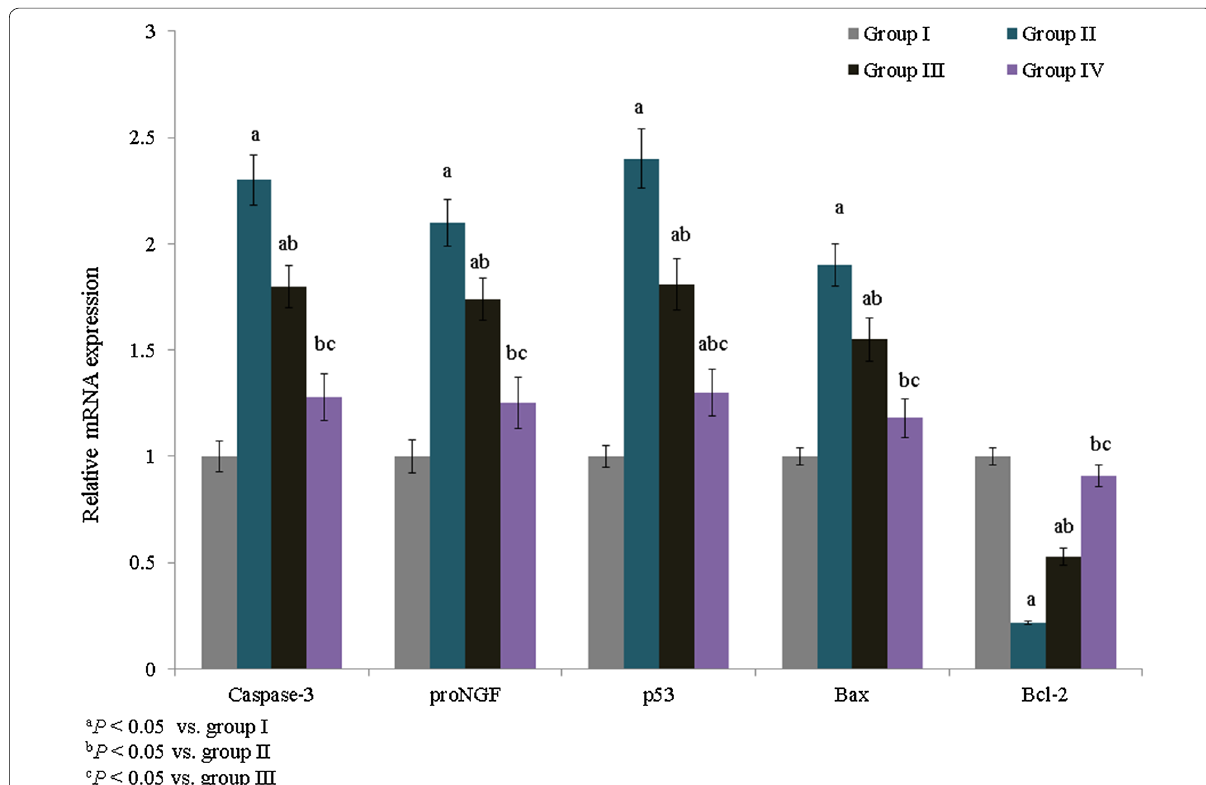
Fig. 5 Effect of E. hirta extract on the mRNA expression of caspase-3, proNGF, p53, Bax, and Bcl-2 in neonatal asthmatic rats. Experimental data are given as the mean ±